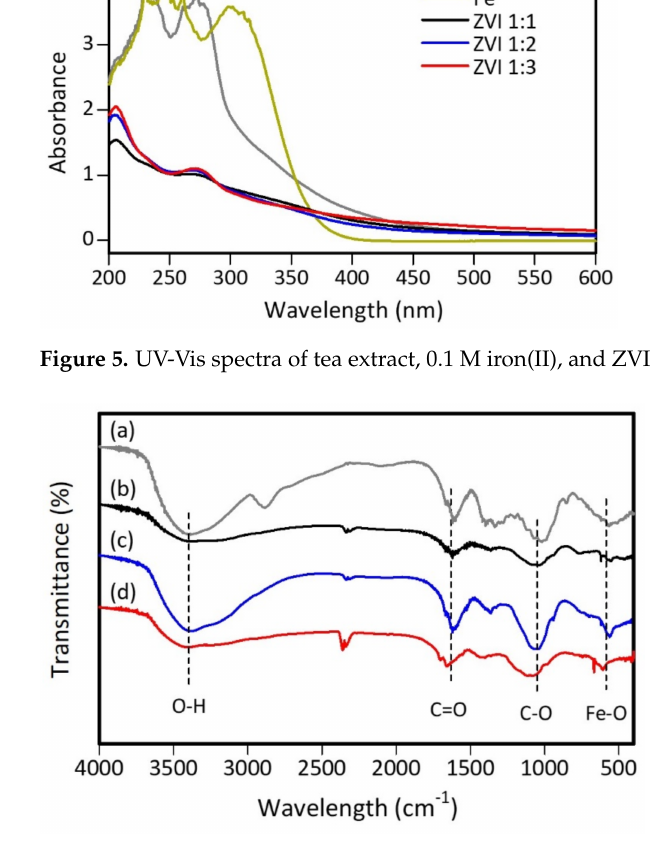
Figure 6. FTIR spectra of ( a ) tea extract, ( b ) ZVI 1:1, ( c ) ZVI 1:2, and ( d ) ZVI